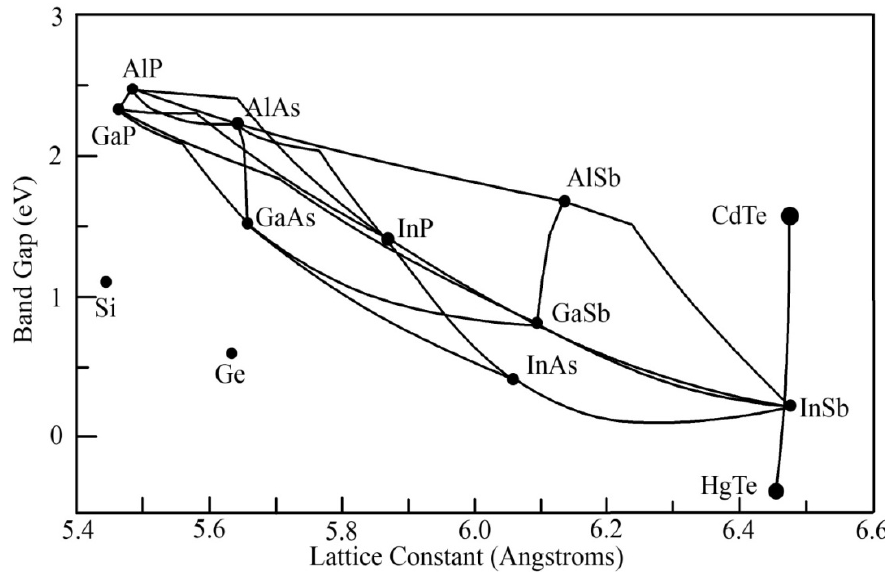
Figure 2. A lattice constant vs. band gap plot of common semiconductor